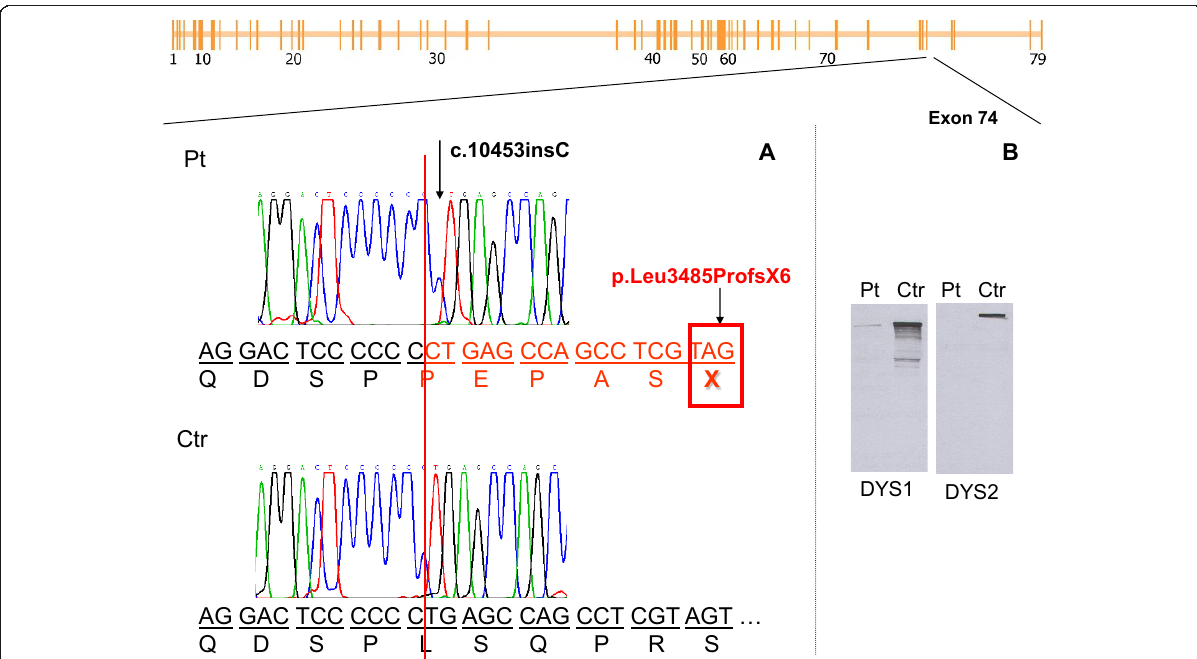
Figure 2 Patient I: stop codon at the 3 ’ end of DMD gene in mild BMD phenotype . Molecular and muscle biopsy features in patient I. The patient showed a mild BMD phenotype and carried a mutation that creates a stop codon at the 3 ’ end of the DMD gene. In the upper part of the figure, the schematic representation of the DMD gene depicts the position of the mutation, which is located in exon 74. A. Sequence analysis of genomic DNA. Pt (Patient I): The electropherogram depicts the single base pair insertion c.10453insC (black arrow). Under the electropherogram, the predicted amino acid sequence demonstrates the effect of the mutation, which leads to the out-of-frame transcript p. Leu3485ProfsX6. Ctr: Control. B. Dystrophin Western blot analysis of a muscle biopsy sample from patient I revealed decreased immunoblot staining with antibody directed against the dystrophin mid-rod domain (DYS1), and absence of signal with antibodies directed towards the C-terminal epitope (DYS2). Ctr: Control muscle sample.